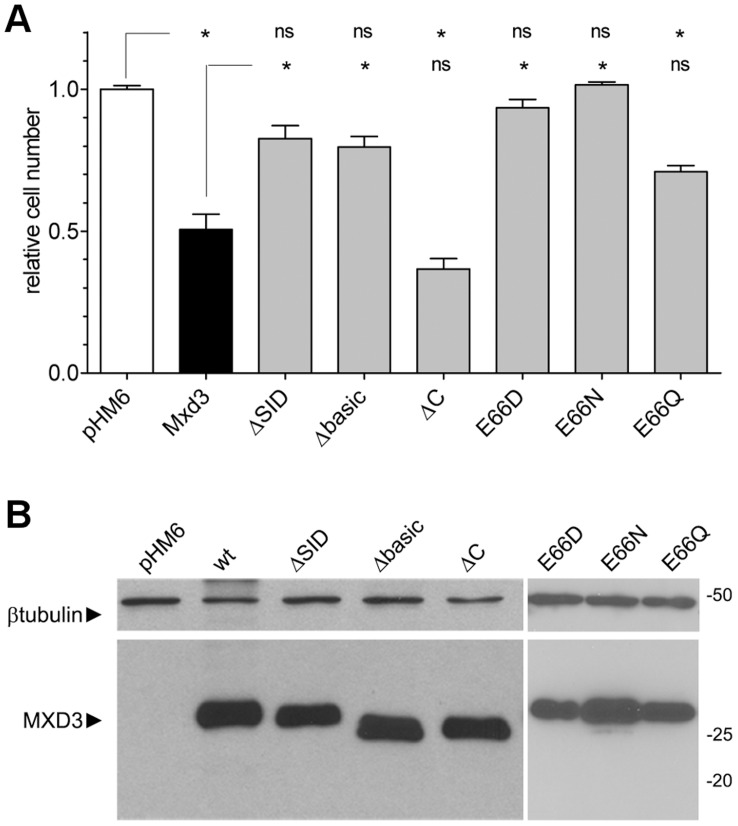
MXD3 structure-function analysis.(A) Quantification of cell proliferation (as total number of cells relative to control) of DAOY cells transfected with full-length MXD3 or mutated forms as indicated in Figure S2. MXD3-transfected cells showed 50% reduction of proliferation compared with vector-only (pHM6). Transfection of ΔC and E66Q constructs resulted in similar reduction in proliferation as full-length MXD3. Transfection of the ΔSID, Δbasic, E66D and E66N constructs had no effect on proliferation compared to control (ns, not significant; asterisks, p<0.001; n  = 4, one-way ANOVA with Bonferroni’s multiple comparison test). (B) Immunoblot analysis of total protein extracts from DAOY cells transfected with the MXD3 constructs in (B). All constructs used expressed the expected proteins at similar levels. Bottom panel, anti-HA; top panel, anti-β-tubulin used as a load control. Molecular mass markers are indicated on the right.